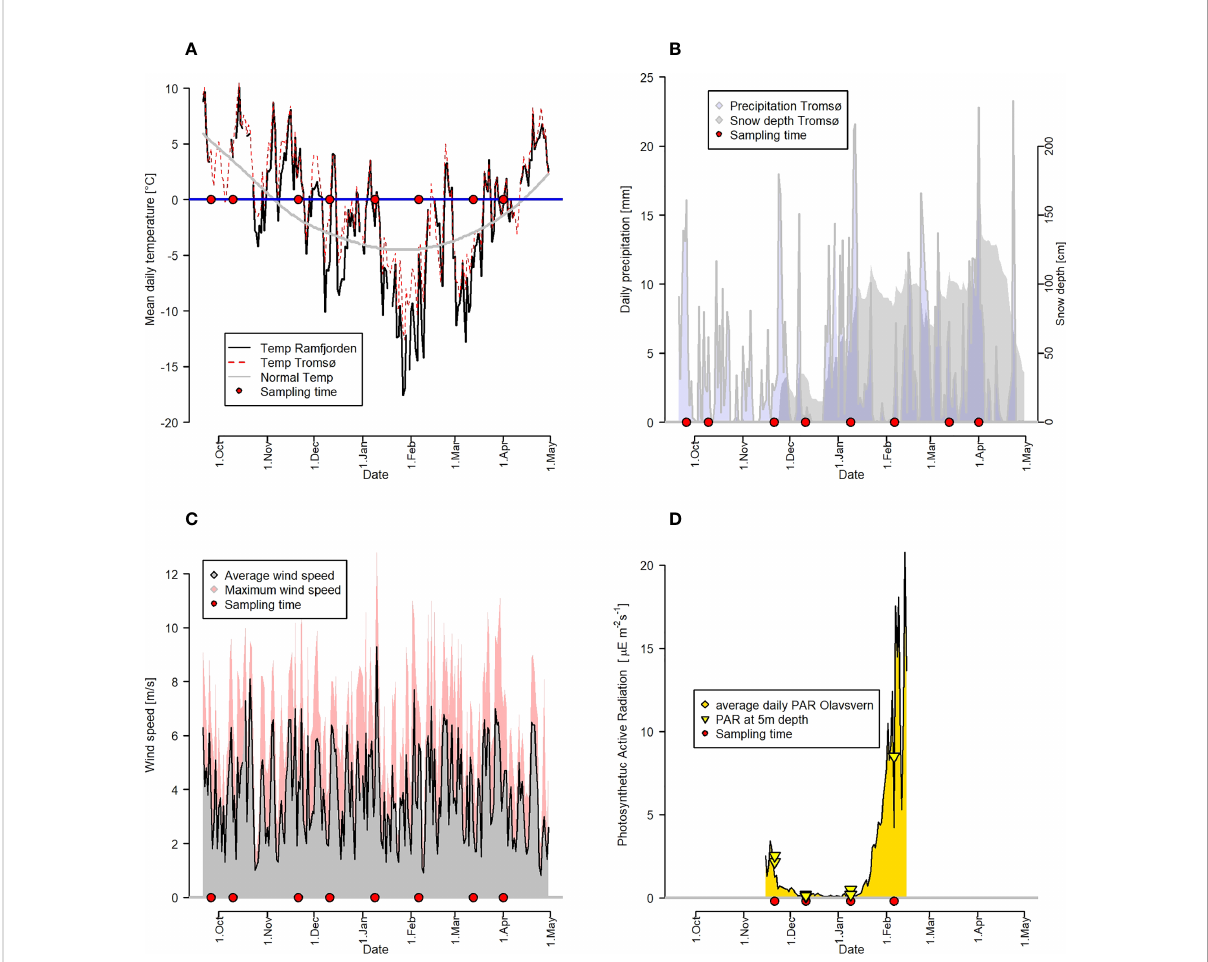
FIGURE 2 Meteorological data in Tromsø and Ramfjorden. Sampling events are marked with a red circle. (A) Daily average temperatures in Tromsø (red line) and Sandvikeidet/Ramfjord (black line) in relation to average temperatures averaged over the past decades (grey line). (B) Daily average (blue area) precipitation and snow depth (greay area) for Tromsø. (C) Daily average (grey area) and daily maximum (red area) wind speeds for Tromsø. (D) Irradiance data (PAR) measured at Olavsvern north of st3 (daily average as yellow area), and at 5 m depth during the sampling (yellow